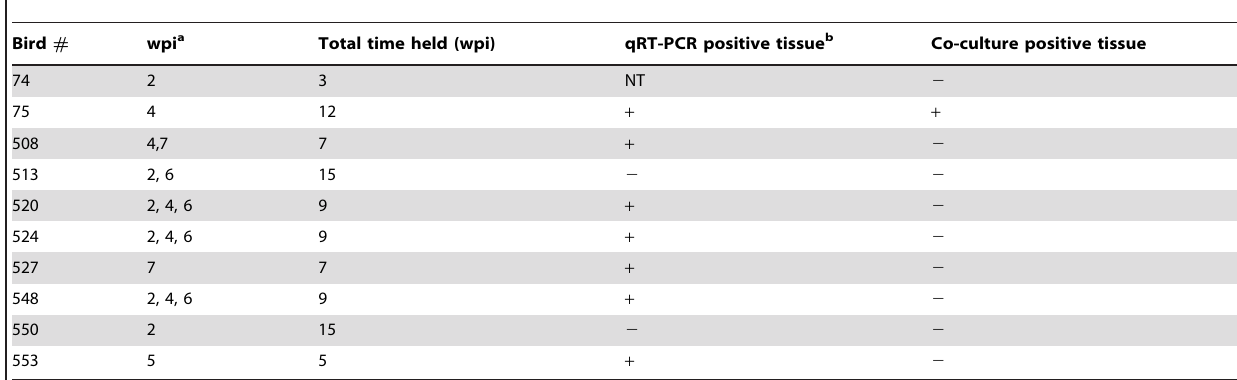
Table 2. House Sparrows ( Passer domesticus ) with serum positive for WNV RNA beyond the acute infection period $ 2 weeks post- infection.